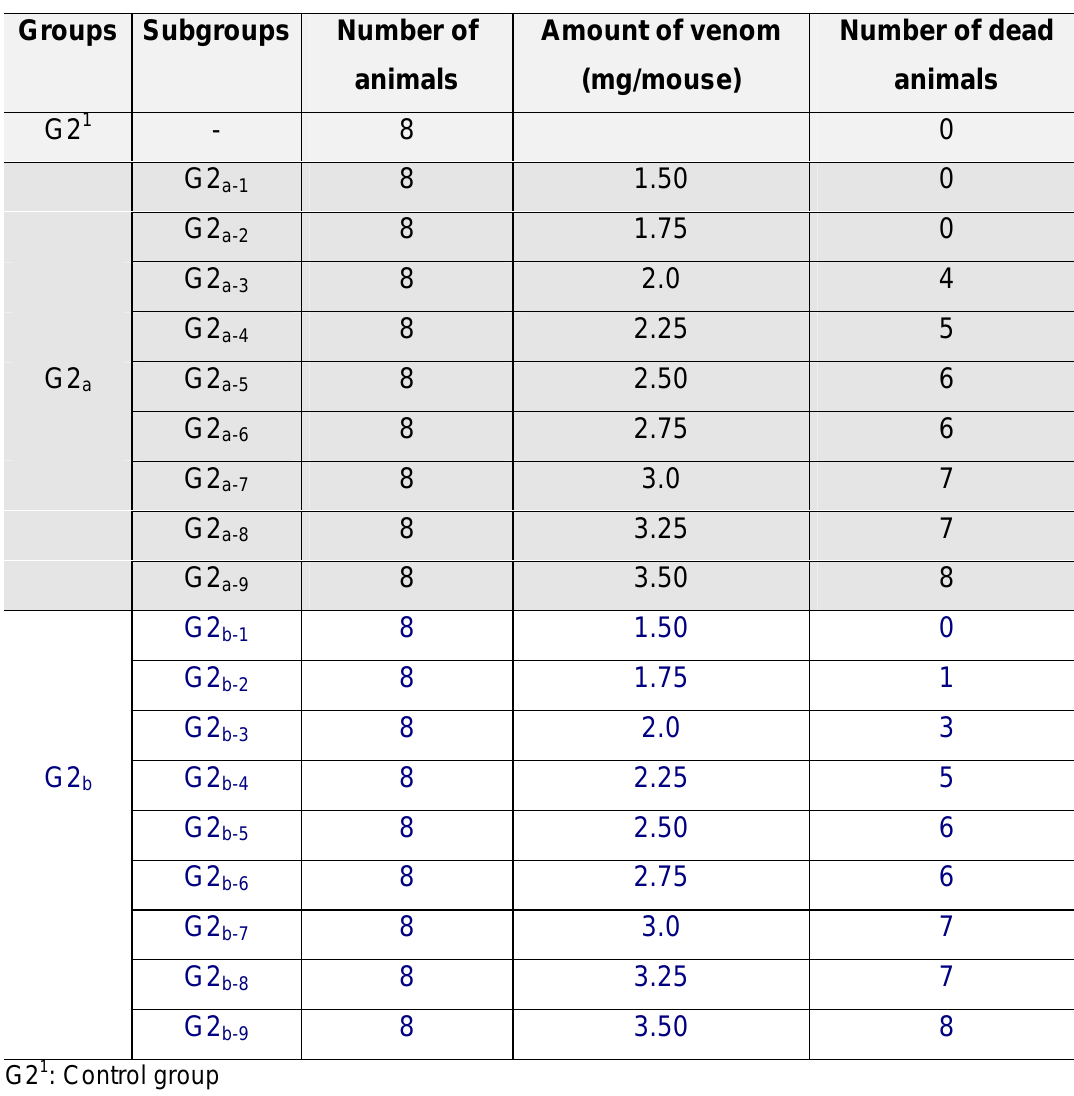
Table 2B: Number of animals in each subgroup, amount of venom used, and number of dead animals in Group 2 (injected with venom solution from telsons weighting from 20 to